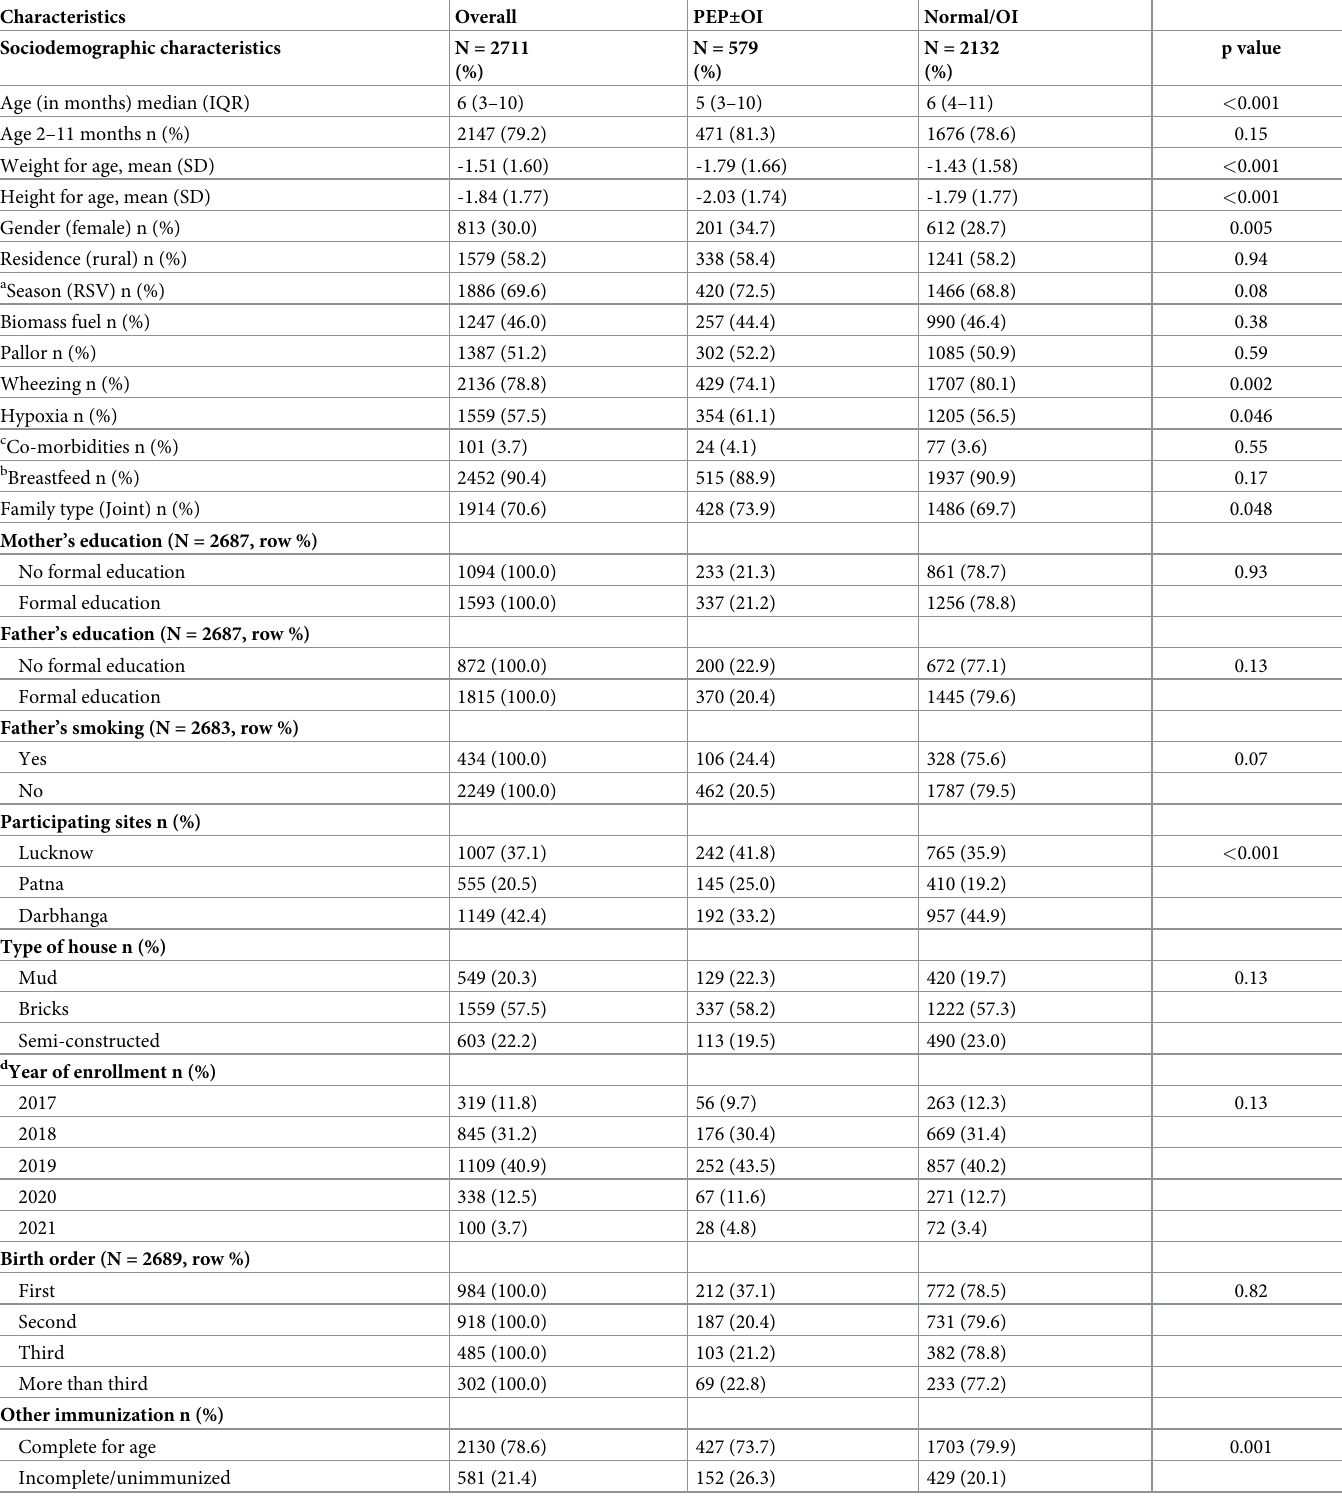
Table 1. Overall descriptive statistics and comparison of sociodemographic and clinical variables among the children with or without PEP ± OI.